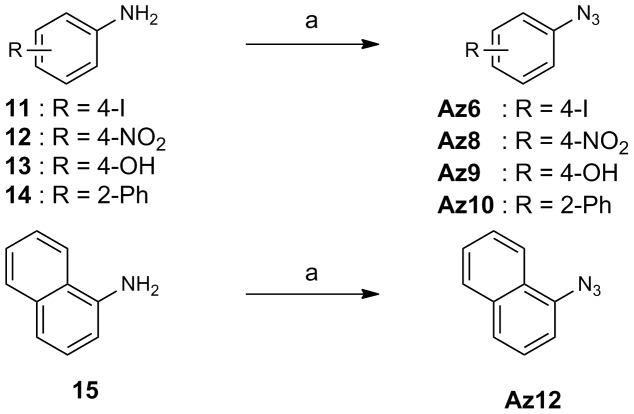
Scheme for the synthesis of Az6, Az8–Az10, and Az12.Reagents and conditions: (a) i) NaNO2, H2O, TFA, 0°C; ii) NaN3, H2O, 0°C to room temp, 18–90%.